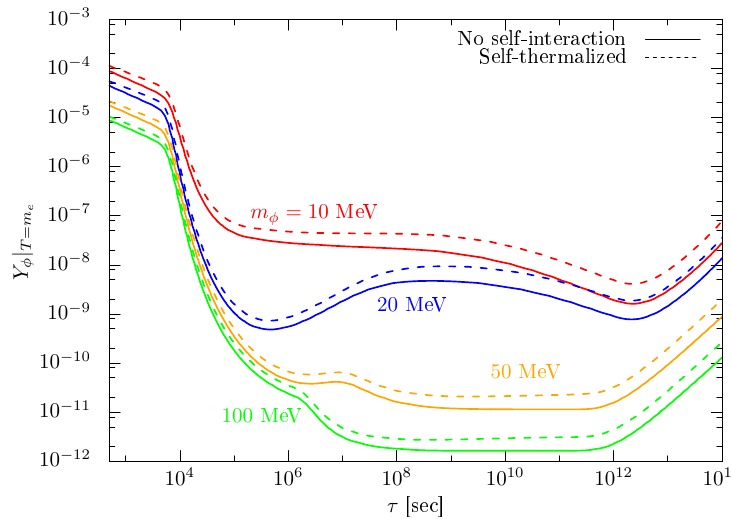
Figure 14. The upper limit on the abundance of the dark scalar at T = m e from BBN constraints. We plot the bounds as functions of the lifetime of the dark